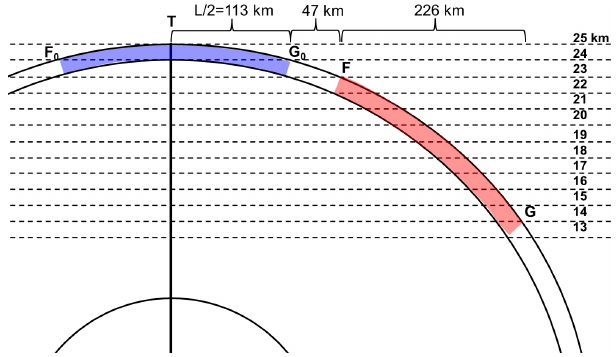
Figure 4. Ratio of real and observed heights for a cloud 1km thick and 226km long, the center of which is located at different distances from the tangential